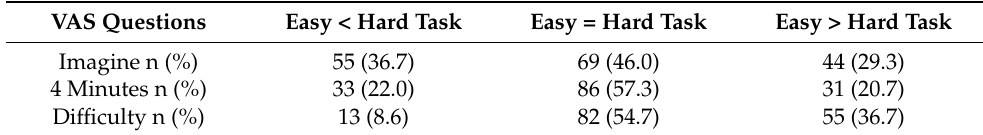
Table 3. Comparison of VAS scores between the Easy and Hard MI